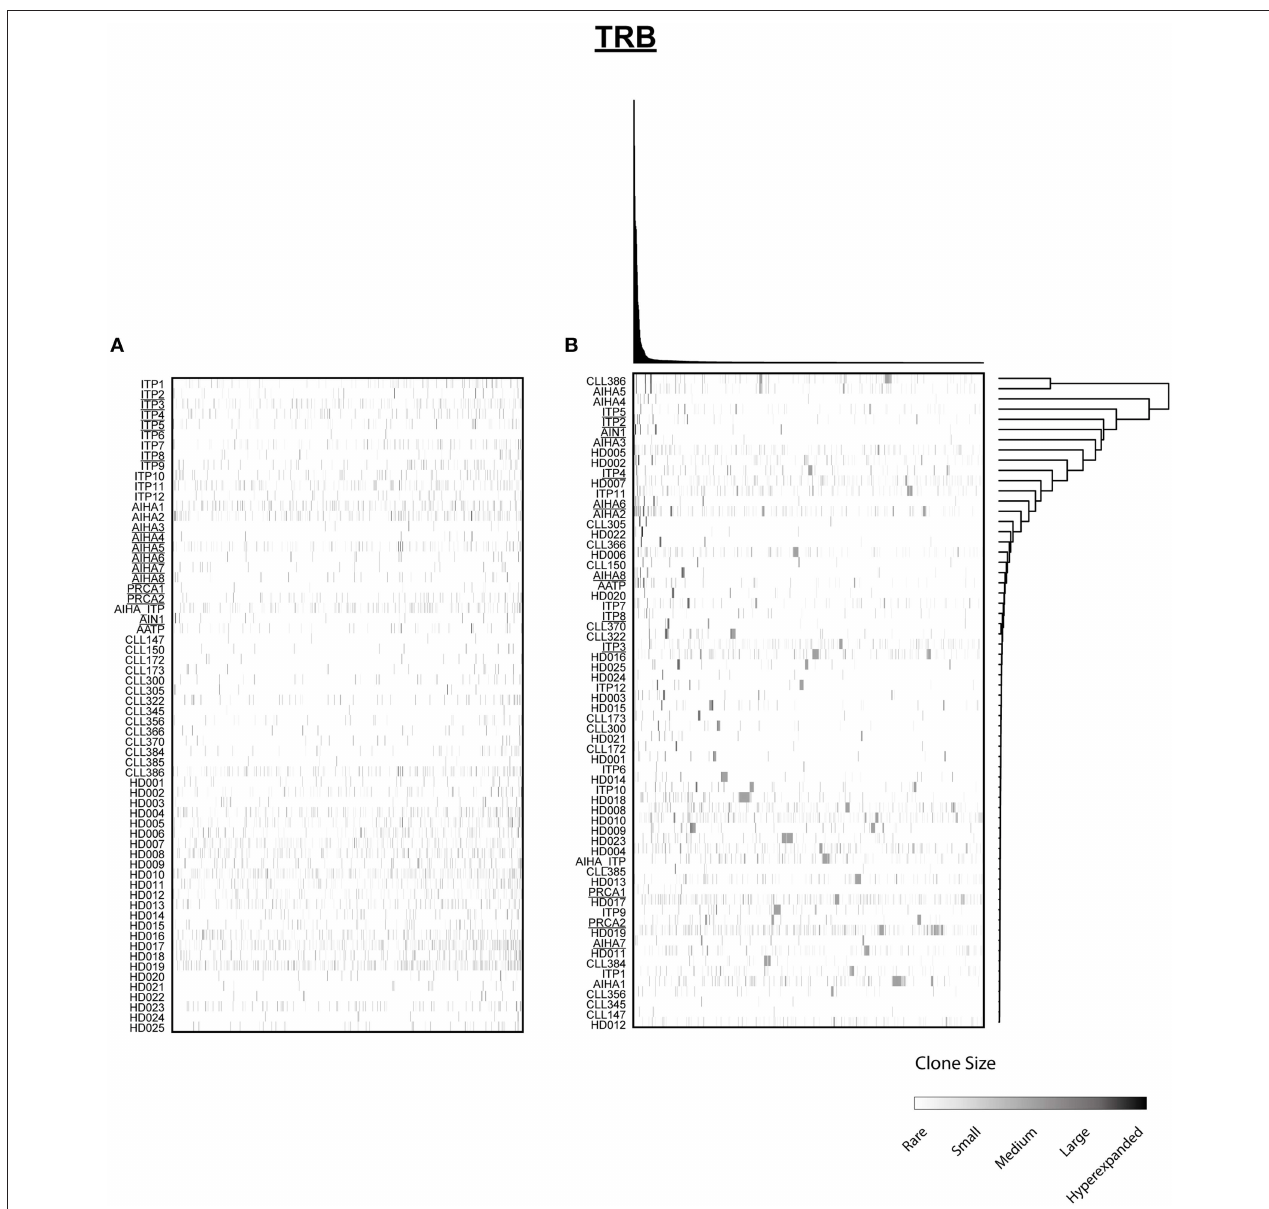
FIGURE 3 | Distribution of shared T cell clones in AIC and control cohorts. T cell clones that were shared between at least 3 cases out of 64 patients and HD are shown. (A) Clustering by disease entity/control group. (B) Unsupervised hierarchical clustering. Color code illustrates frequency of individual clone within a repertoire. Secondary AIC Patients are